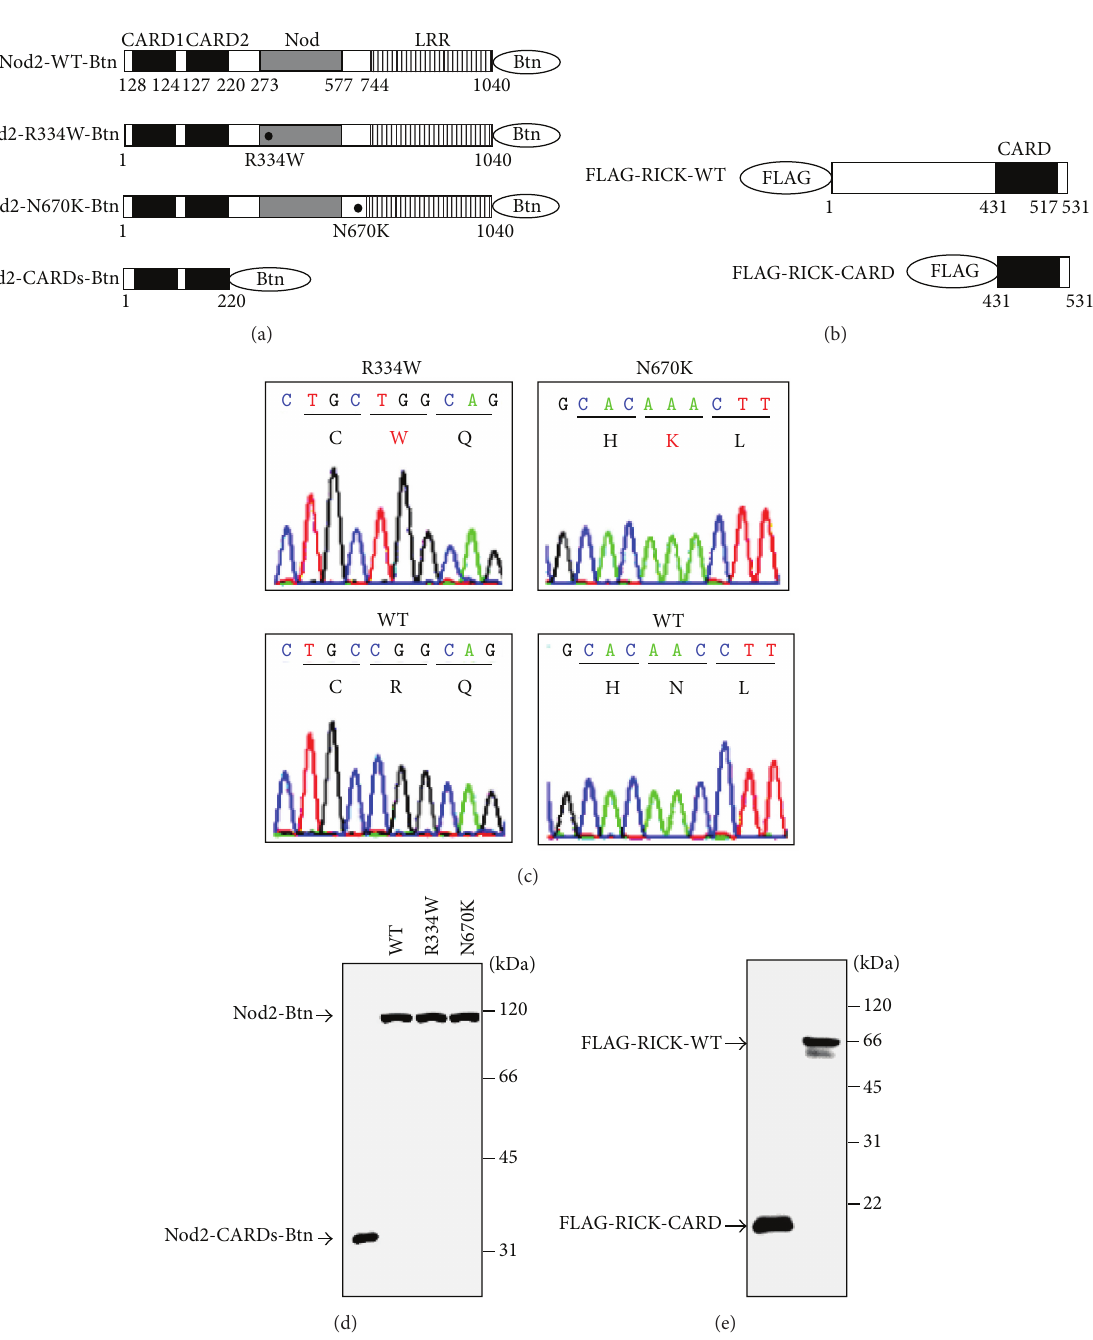
Figure 1: Schematic representation of Nod2 and RICK, and sequencing chromatograms of Nod2 plasmids containing the BS/EOS-associated mutations, and protein syntheses. (a) Schematic representations of biotinylated wild-type and mutant Nod2. C-terminal biotinylated full- length wild-type Nod2 (Nod2-WT-Btn), full-length R334W-mutated Nod2 (Nod2-R334W-Btn), full-length N670K-mutated Nod2 (Nod2- N670K-Btn), and tandem CARD1- and CARD2-domains-only Nod2 (Nod2-CARDs) are indicated. (b) Schematic representations of FLAG- tagged wild-type and CARD-domain-only RICK. N-terminal FLAG-tagged full-length RICK (FLAG-RICK-FL) and CARD-domain-only RICK (FLAG-RICK-CARD) are indicated. The caspase recruitment domain (CARD) is indicated by black boxes. The nucleotide-binding oligomerization domain-containing protein (Nod) is indicated by grey boxes. Leucine-rich repeats are indicated by striped boxes. Amino acid sequence number and mutated amino acids are indicated under each schema. (c) Sequencing chromatograms of Nod2 and mutated-Nod2 plasmids. The wild-type and mutated-Nod2 plasmids pDONR221-Nod2-WT, pDONR221-Nod2-R334W, and pDONR221-Nod2-N670K were sequenced to confirm (from CGG to TGG corresponding to R334W in the right panel; from AAC to AAA corresponding to N670K in the left panel) mutations at the appropriate site. (d) Western blotting analysis of biotinylated Nod2 and its mutants. A total of 1.5 𝜇 g of synthetic protein was subjected to SDS-PAGE followed by Western blotting. Protein detection on themembranes was performed using HRP-conjugated streptavidin. Molecular weights are indicated at right. (e) Western blotting analysis of FLAG-tagged RICK and CARD-domain-only RICK. A total of 1.5 𝜇 g of synthetic protein was subjected to SDS-PAGE followed by Western blotting. Protein detection on the membranes was performed using anti-FLAG mAb M2. Molecular weights are indicated at